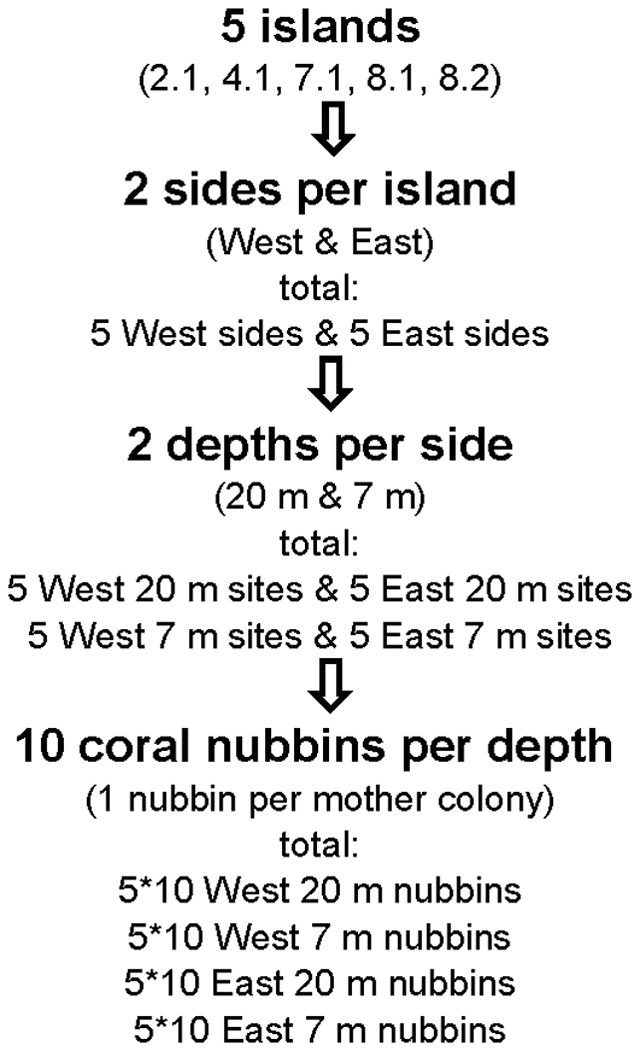
Experimental design of Porites lutea growth rate experiment.For the experiment in each case 20 coral nubbins were collected from 10 mother colonies at a sheltered east site in 7(close to E 8.1, cf. Fig. 1) and transplanted to the west and east sides of 5 islands at 2 depths (7 m and 20 m) from February 2007 to February 2008 along the Similan Islands (cf. Fig. 1).